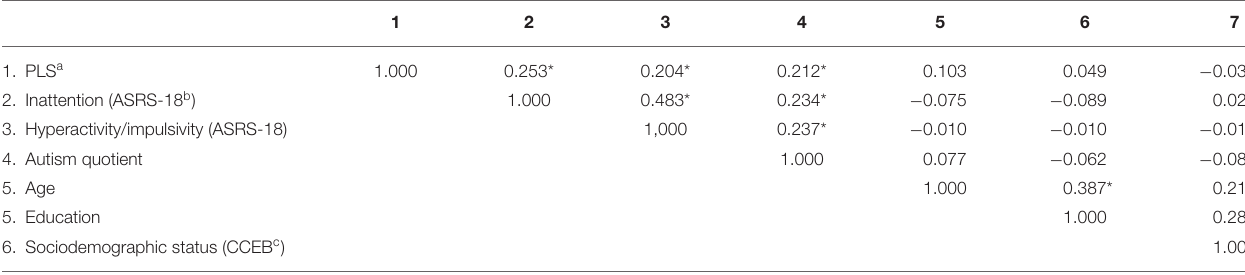
TABLE 3 | Participants’ correlations among passionate love and symptoms of autism and ADHD.